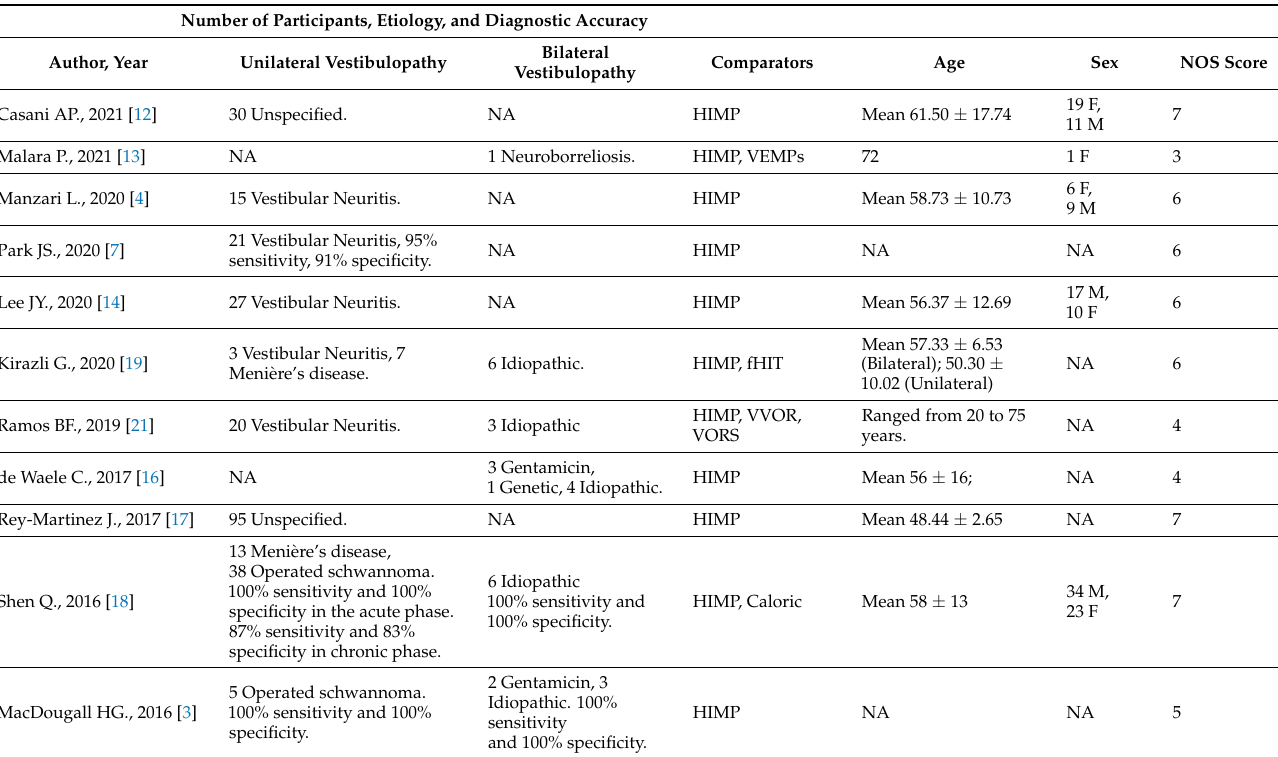
Table 1. Demographic and Clinical Characteristics of Participants.